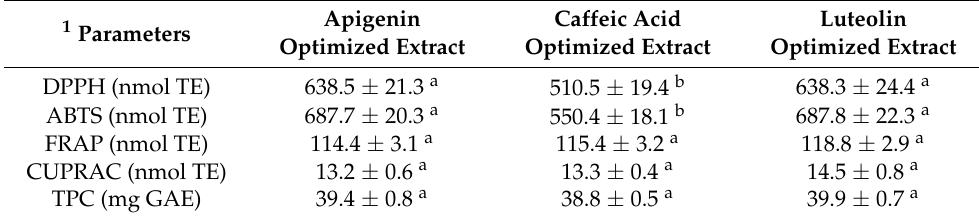
Table 6. Antioxidant activities of parsley optimized